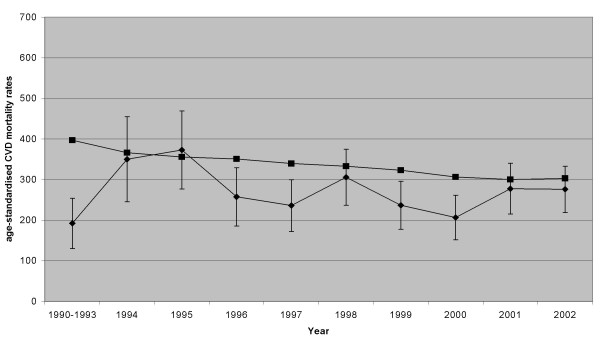
Directly age-standardised CVD mortality rates and 95 % confidence intervals for women in the cohort (◆) and women in the general German population (■). Rates are presented as per 100,000 person years/population.